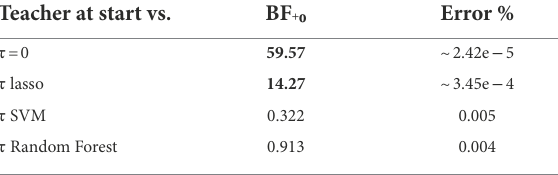
TABLE 5 Bayesian one-sample t -test for Kendall’s τ of the teachers at start-predictions ( M = 0.16, SD = 0.09) with chance level (Kendall’s τ of 0) and Kendall’s τ of the various ML models. Teacher at start